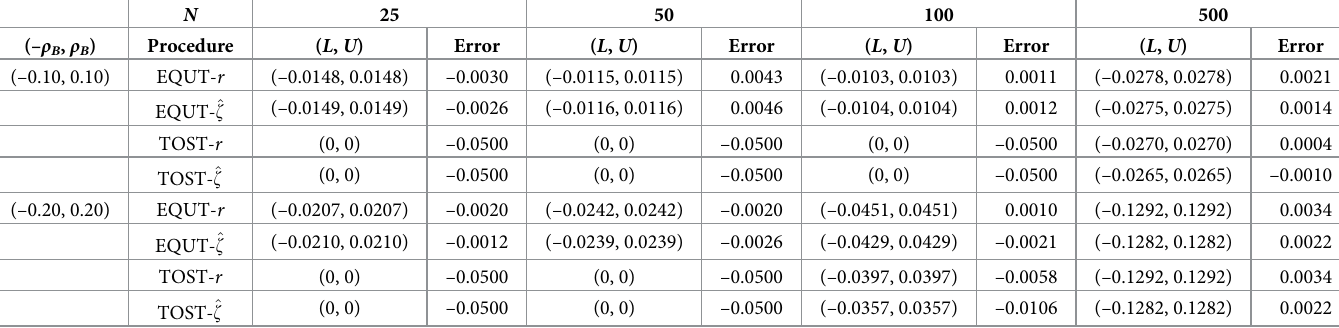
Table 3. The critical intervals and simulated errors of the lack of association tests for α =